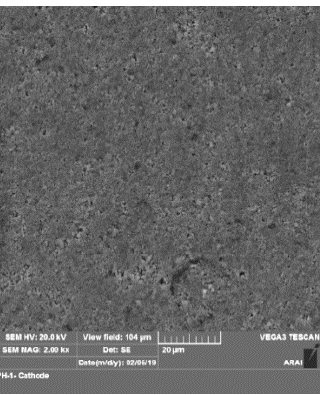
Figure 6. Nail-penetrated cell cathode with location away from centre (50% SoC).